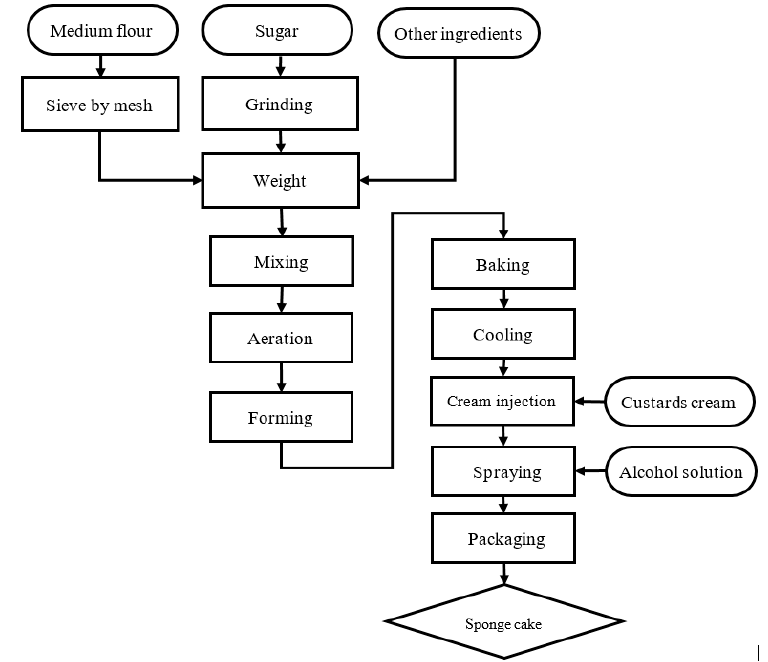
Figure 2. The procedure for preparation of sponge cake.